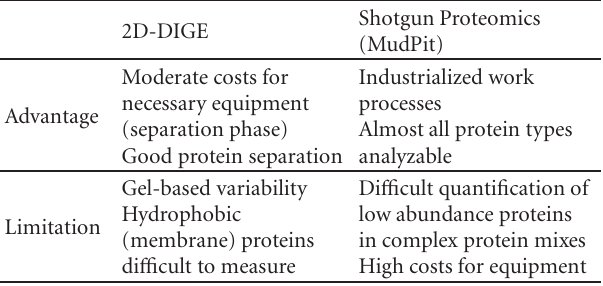
Table 2: Advantages and limitations of the two major proteomics